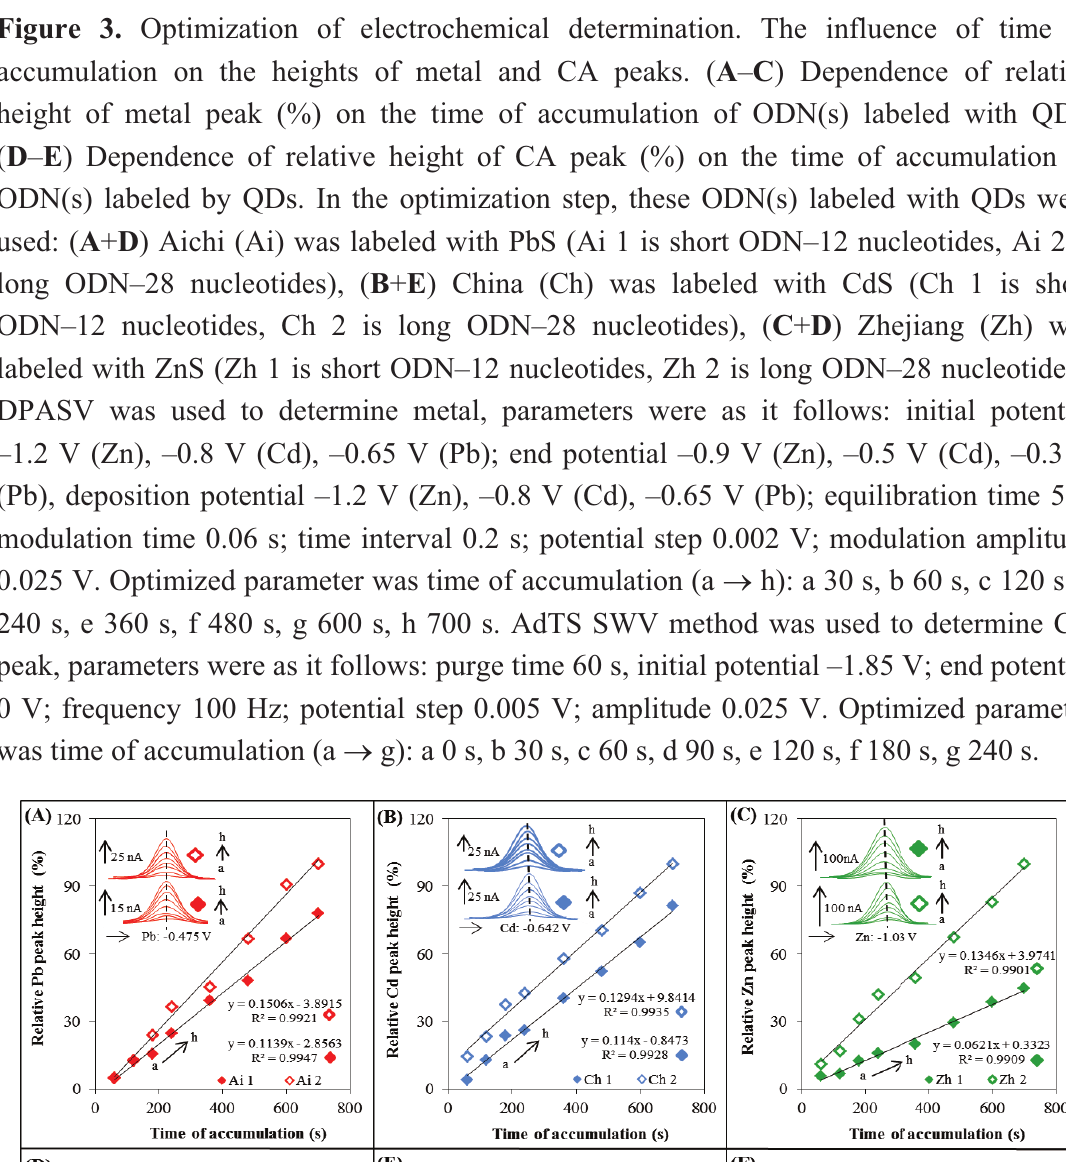
Figure 3. Optimization of electrochemical determination. The influence of time of accumulation on the heights of metal and CA peaks. ( A – C ) Dependence of relative height of metal peak (%) on the time of accumulation of ODN(s) labeled with